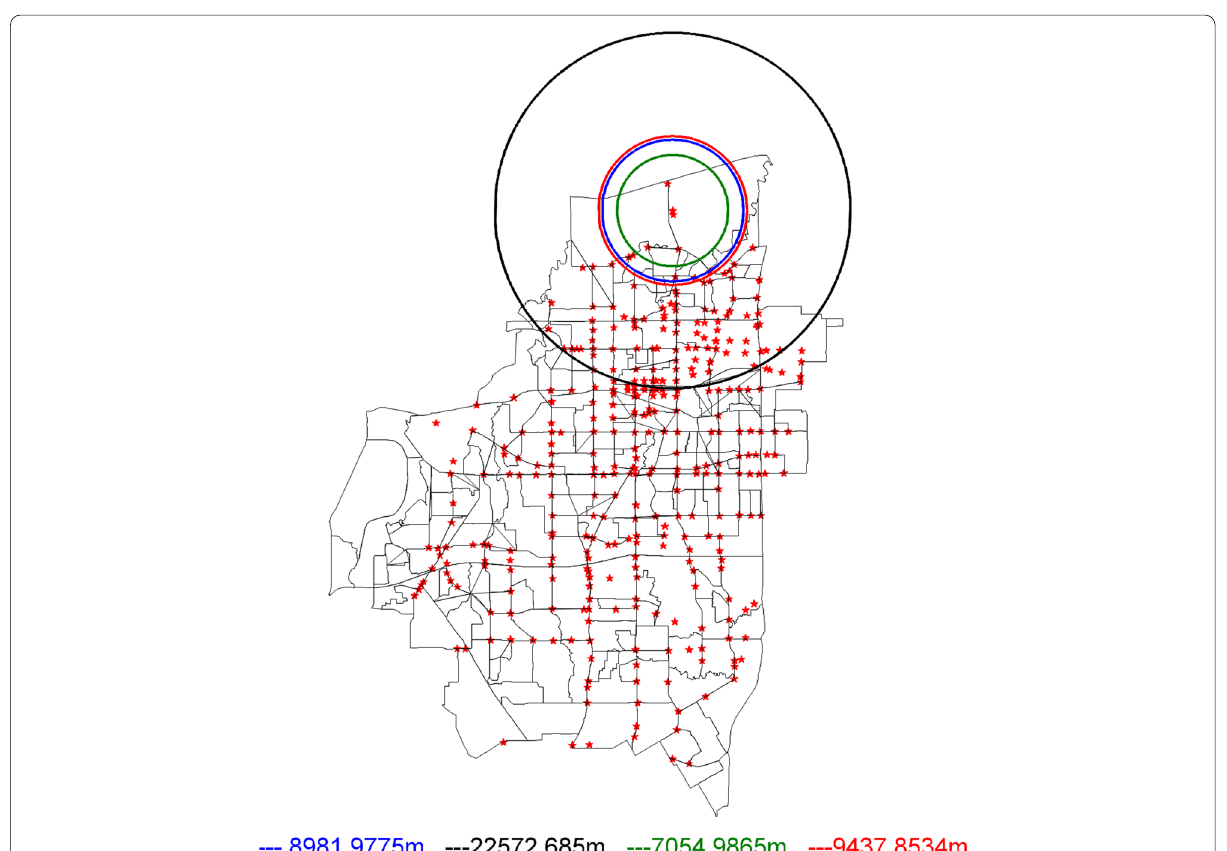
Fig. 2 Example of the optimum bandwidth for some distances in a specific location